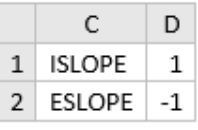
Figure A5 . Optional input format to QUADXY for endpoints boundary conditions.